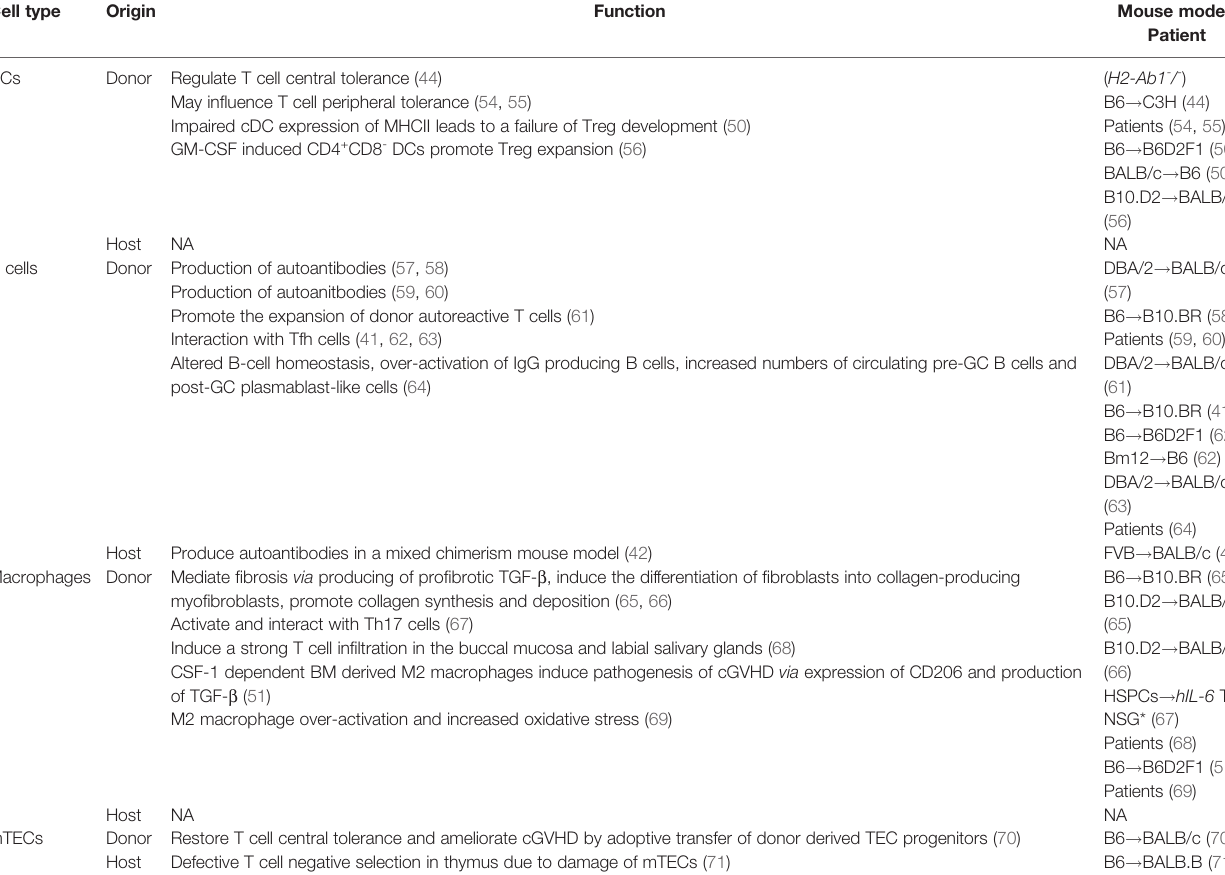
TABLE 1 | Distinct origins and functions of antigen presenting cells (APCs) in chronic graft-versus-host